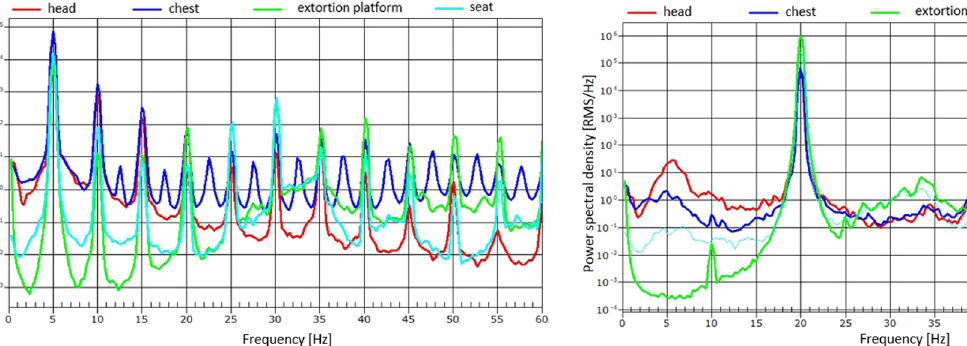
Figure 9: PSD for the 5 Hz excitation for the vertical direction.